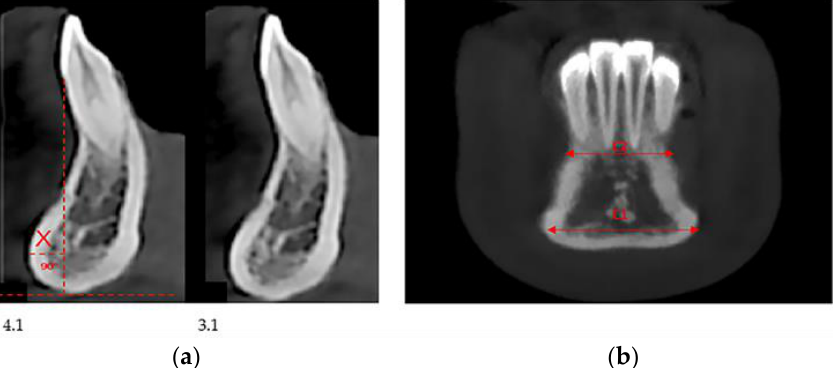
Figure 2. Cone beam Computed Tomography (CBCT) measurements in the paraxial 4.1, 3.1. measurement X-plane ( a ) and coronal measurement C2 and C1 ( b ) plane.